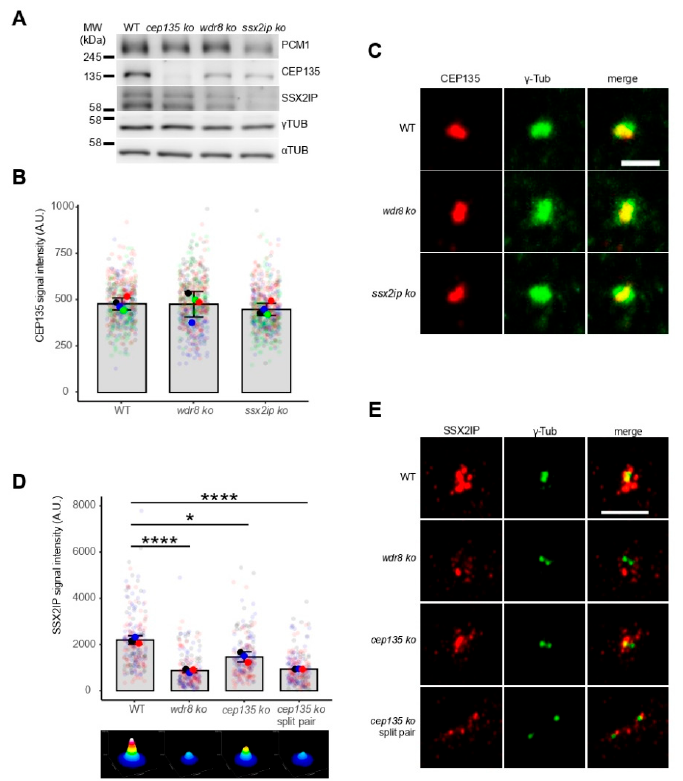
Figure 3. Protein expression and centrosomal localization of CEP135, WDR8, and SSX2IP are inter- dependent in RPE-1 cell lines. ( A ) Immunoblotting to show expression levels of PCM1, CEP135, SSX2IP, and γ -tubulin. α -Tubulin was used as a control for total protein loaded. Please note that the SSX2IP antibody tended to reveal unspecific signals in some immunoblots. ( B – E ) Centrosomal CEP135 ( B , C ) and SSX2IP ( D , E ) signals in WT and KO cells as indicated. cep135 KO cells frequently displayed separated centrosomes with two distinct γ -tubulin signals (split pair). Representative immunofluorescence images ( C , E , both with γ -tubulin signals) and quantifications ( B , D ). The ImageJ threshold feature was used to identify the region of the CEP135 signal in ( B ). A square (8.6 µ m in xy ) was drawn with the γ -tubulin signal in the center in ( D ). ( B , D ) Graphs show mean values (fat colored/black dots) of single experiments and individual data points (transparent dots). The added intensity of the two separated γ -tubulin signals (“split pair”) in cep135 KO cells was quantified in ( D ). Three or four independent experiments were performed with more than 500 ( B ) or 210 ( D ) cells measured in each experiment. Errors bars show the SD from means; p -values were calculated with a two-tailed Student’s t -test. * indicates p < 0.05, **** p < 0.001. The surface plots represent sums (ImageJ z -projections) of all images. ( C , E ) Scale bars: 5 µ m ( C ) or 2 µ m ( E